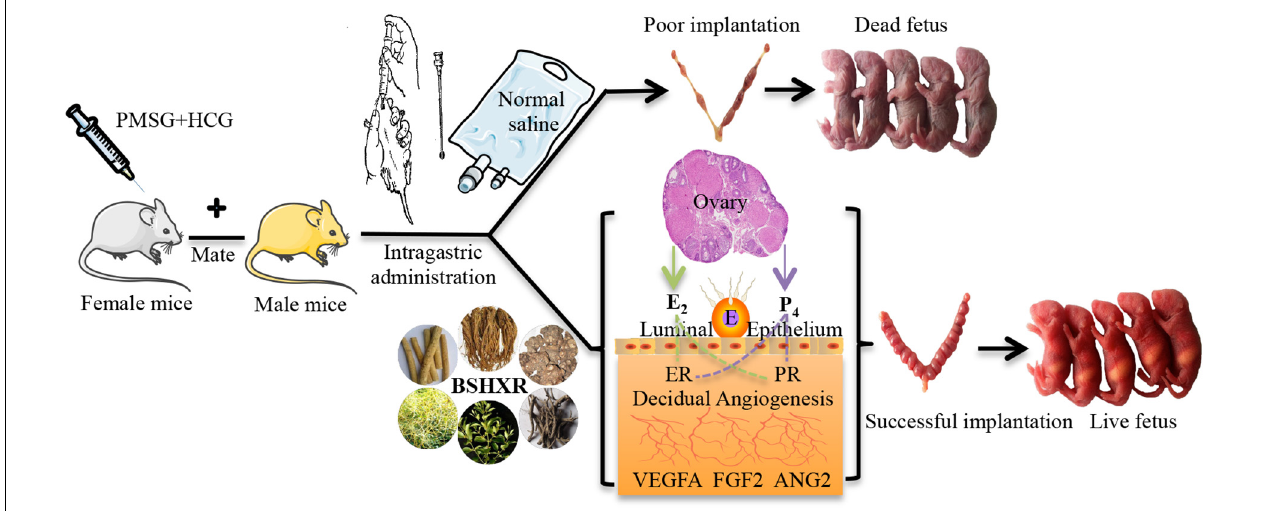
FIGURE 1 | The graphic illustration of experiment. E, embryo; ER, estrogen receptor; PR, progesterone receptor.